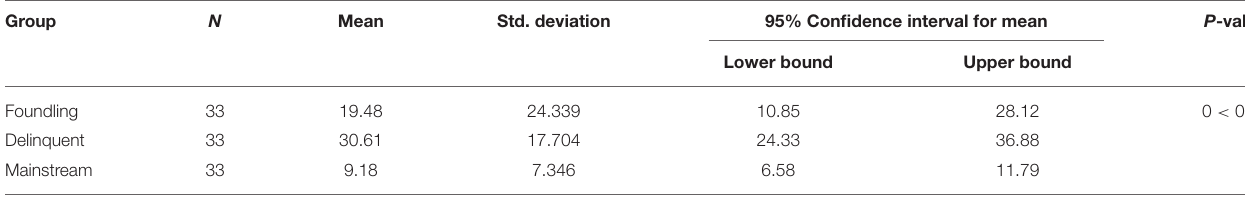
TABLE 3 | Comparison of total OHRQoL score in foundling, delinquent and mainstream children groups. Group N Mean Std. deviation